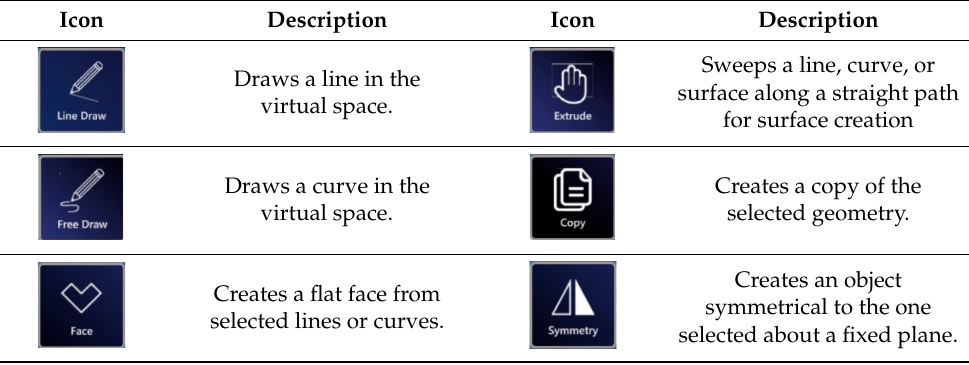
Table 2. Available commands to create geometry.